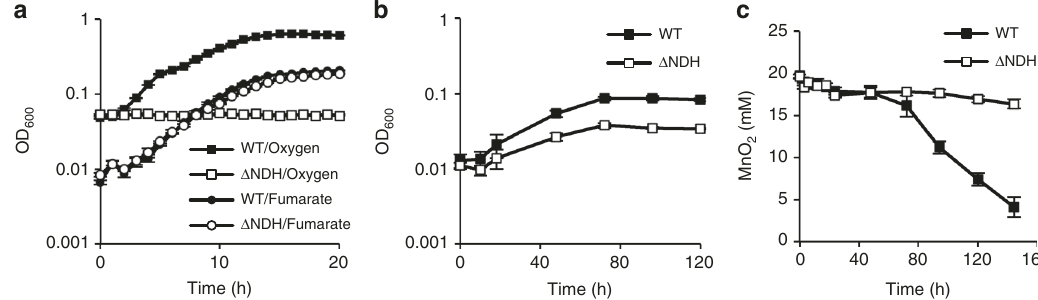
Fig. 4 Growth characteristics of Δ NDH on different electron acceptors. a , b Growth curves of WT and Δ NDH cells grown on pyruvate under aerobic, fumarate-reducing ( a ), and nitrate-reducing ( b ) conditions. c Reduction of MnO 2 by WT and Δ NDH cells. Data points and error bars represent means and s.d., respectively ( n = 3 biological replicates)